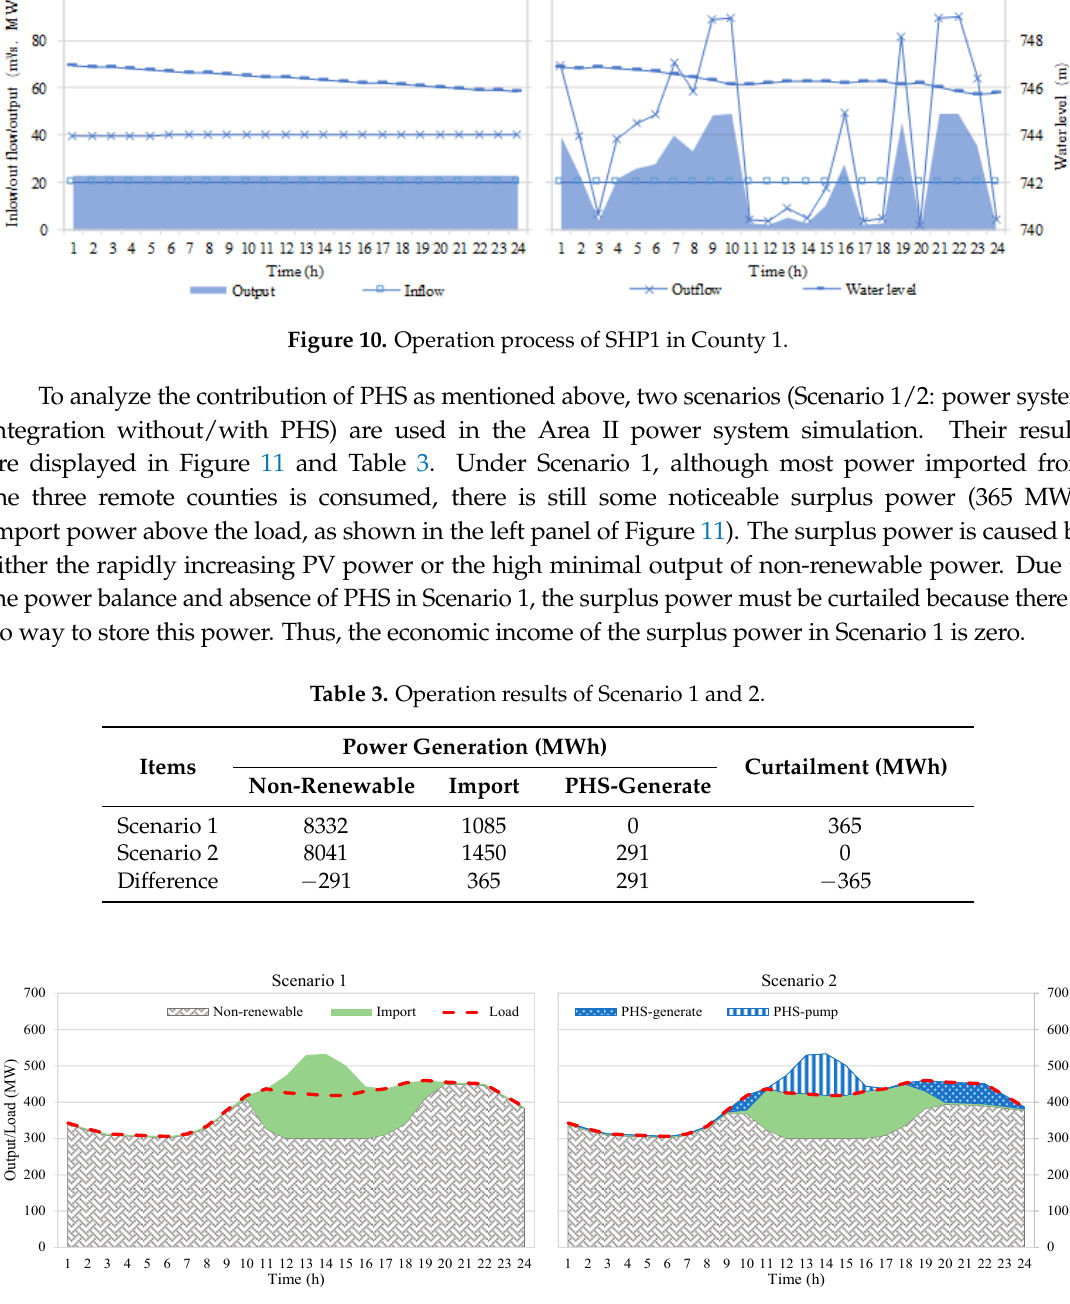
Figure 11. Operation process of the power stations in Area II.